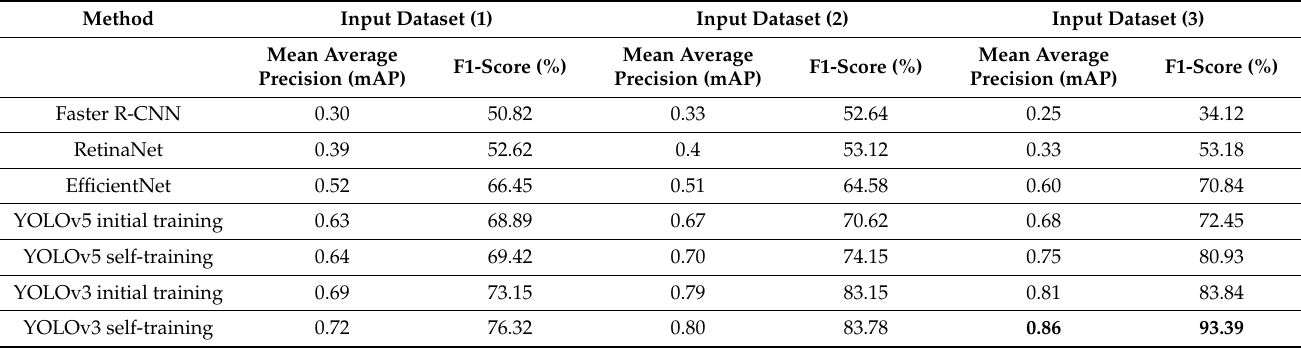
Table 4. Overall training evaluation metrics (best result in bold) on multimodal datasets for an orthophoto product for 30% of the input data (1900 test samples out of 6100 images in